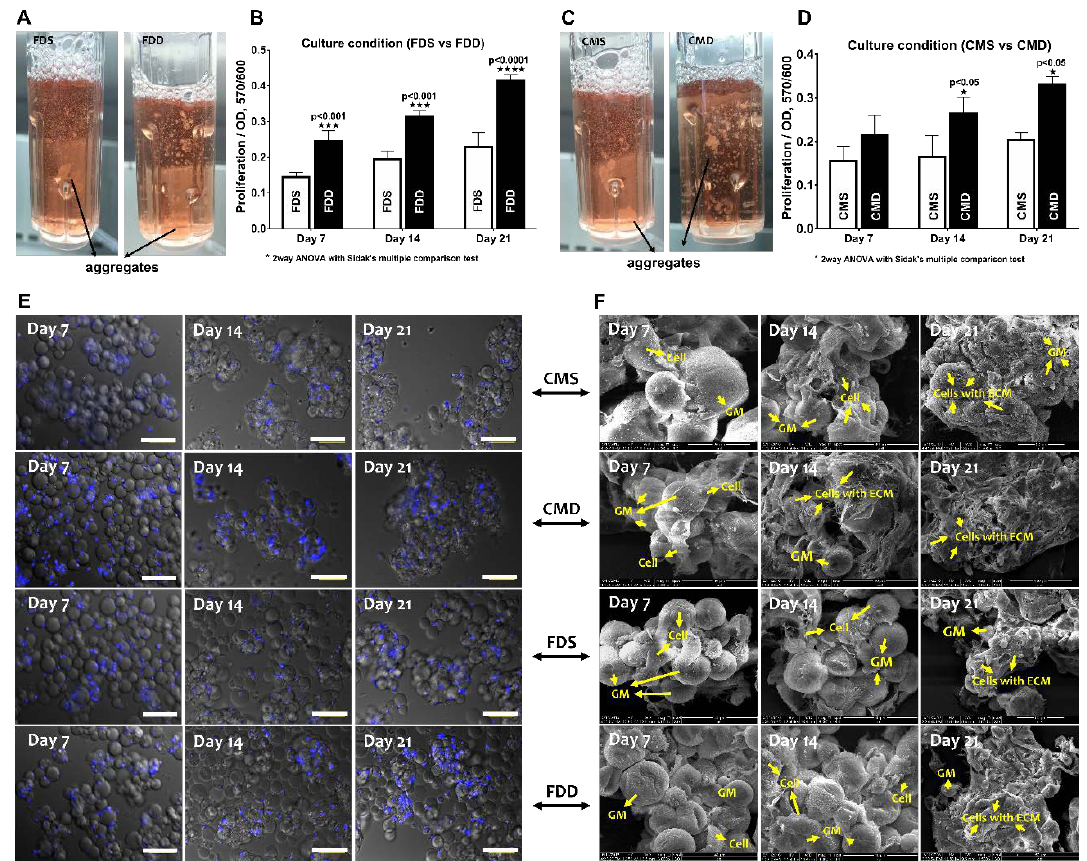
Figure 4. BMSCs attachment and proliferation in the static and dynamic culture system. Evaluation based on the different medium and culture system. ( A , B ) Macroscopically view and proliferation of BMSCs-GM in FDS and FDD culture condition ( C , D ) Macroscopic view and proliferation of BMSCs-GM in CMS and CMD culture condition. ( E , F ) Microscopic view of BMSCs-GM in FDD, FDS, CMD, and CMS. All experiments based on BMSCs-GM incubated in FD and chondrogenic induction medium (CIM) for 7, 14, and 21 days using static and dynamic culture condition (FD-Static (FDS), CIM-Static (CMS), FD-Dynamic (FDD), and CIM-Dynamic (CMD)). The sample size ( n ) for each experiment was six ( n = 6). ( E : 100 × Magnification; scale bar: 100 µ m F : 3000 × Magnification; scale bar: 40 µ